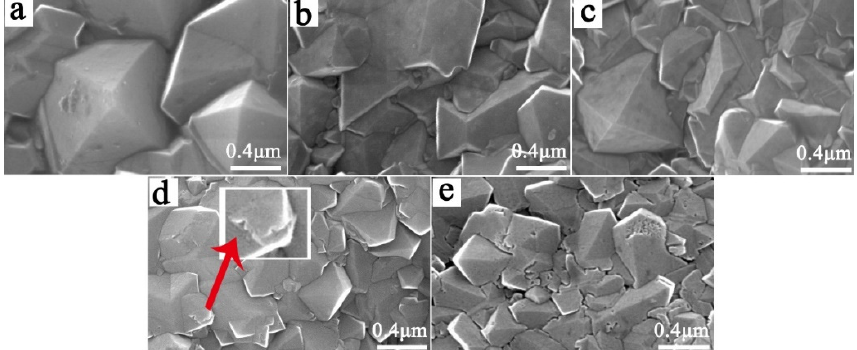
Figure 4. The surface morphology of the samples prepared at di ff erent B source flow rates: ( a ) 0.1 sccm; ( b ) 0.2 sccm; ( c ) 0.4 sccm; ( d ) 0.6 sccm; and ( e ) 0.8 sccm after 10 h of electrolysis. Electrolytic conditions: 1 A / cm 2 current density. The illustration in ( d ) is a magnified image at the grain boundaries.